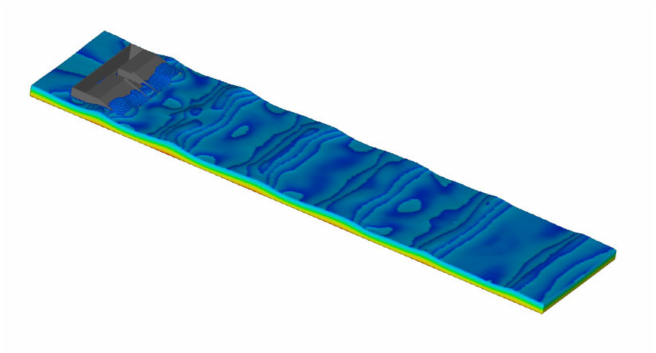
Figure 10. Render and snapshot one of simulation frame.